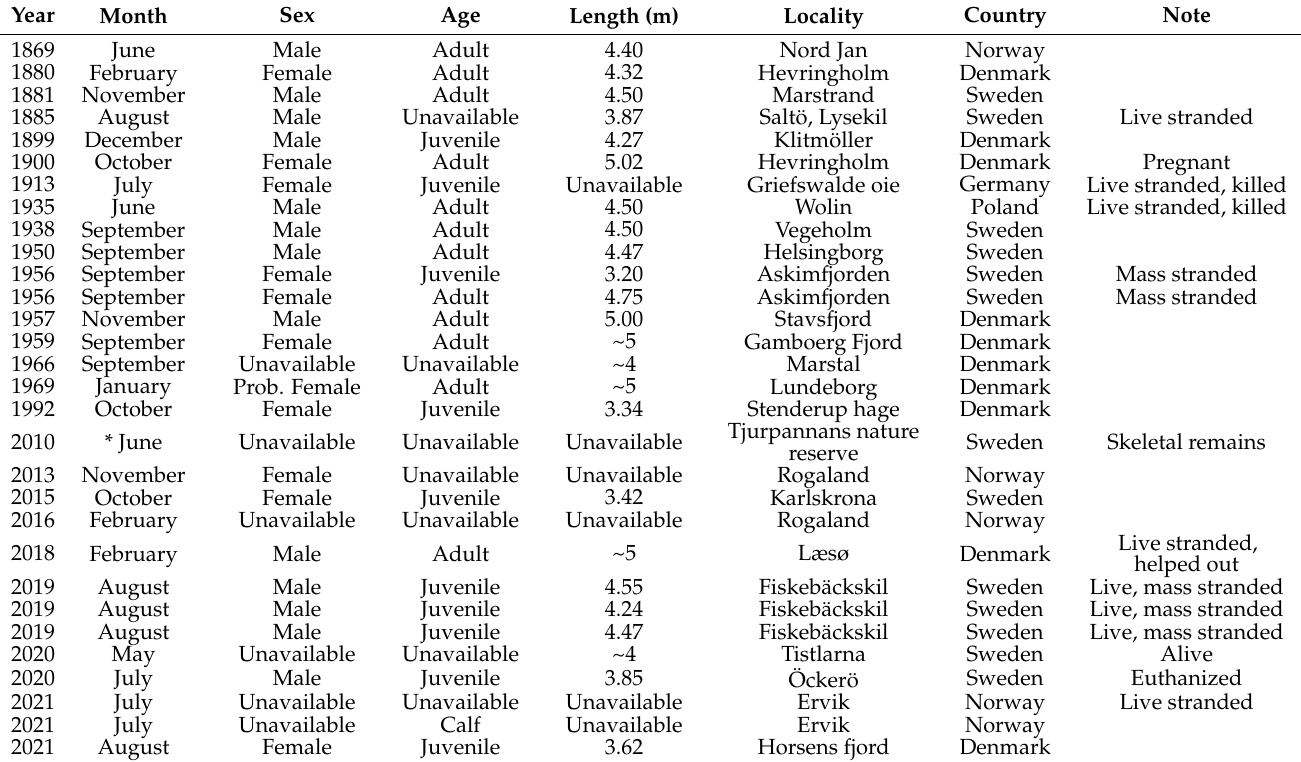
Table A1. Compilation of historical records and connected available data, of Sowerby’s beaked whales 1869–2021, in proximity to the Skagerrak basin and adjacent